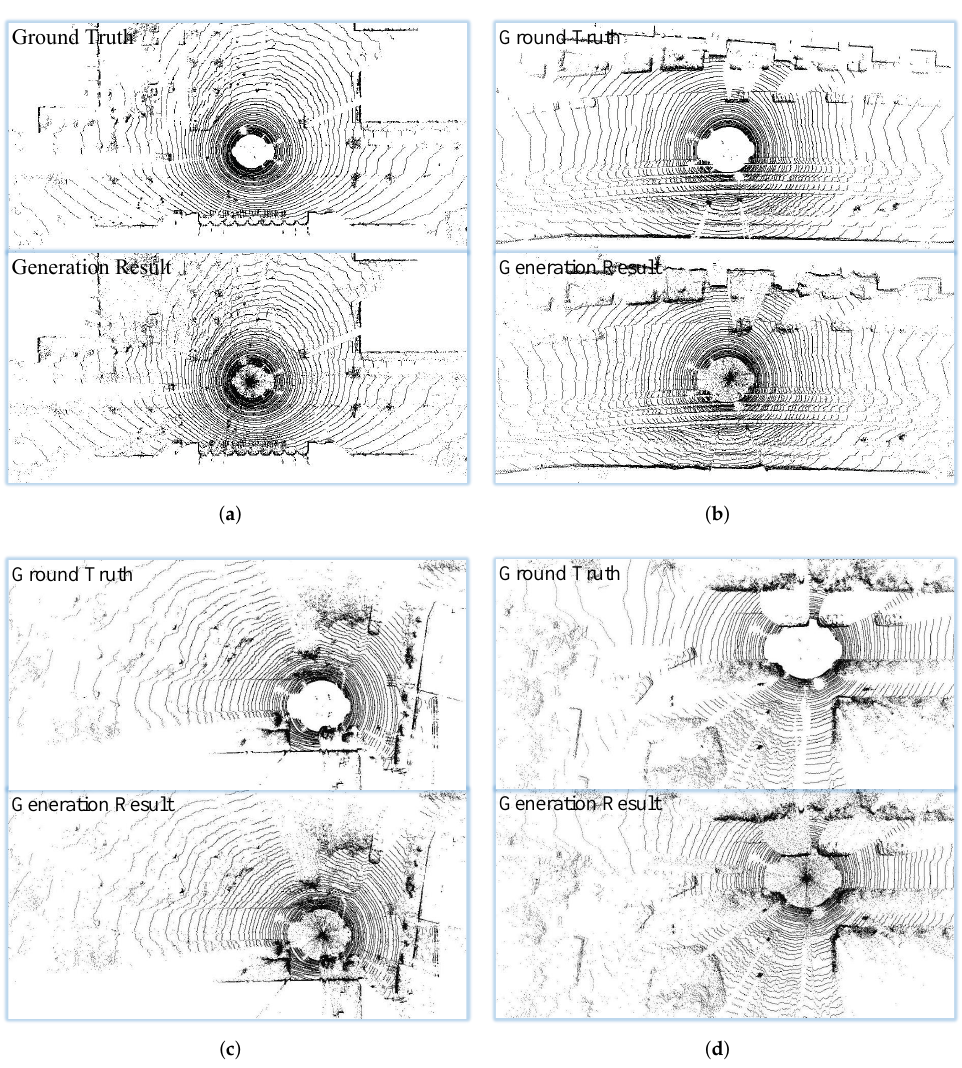
Figure 4. Qualitative results: ( a ) campus; ( b ) city; ( c ) road; ( d ) residential (Best viewed by zooming